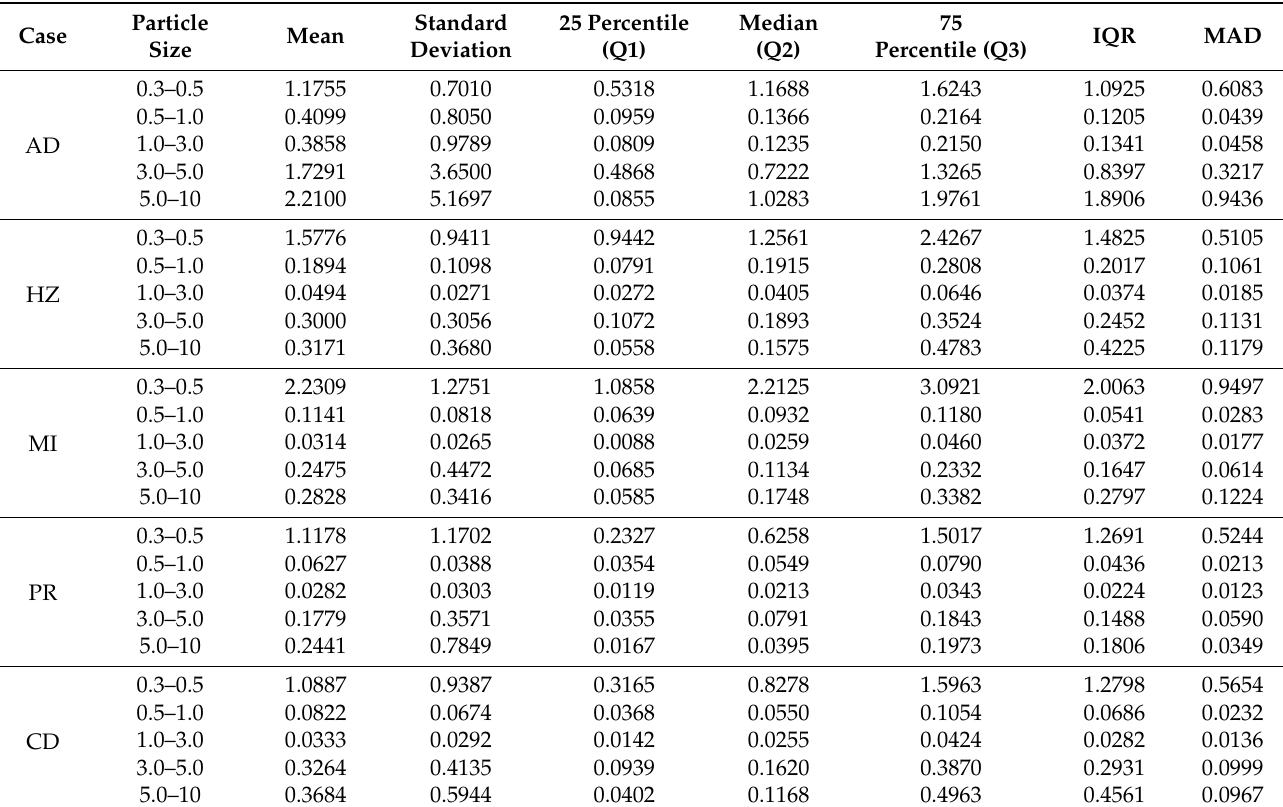
Table 2. Statistical summary for the results of aerosol mass concentration by particle size ( D , µ m) for the instances of meteorological phenomena; all variables are expressed in µ g · m − 3